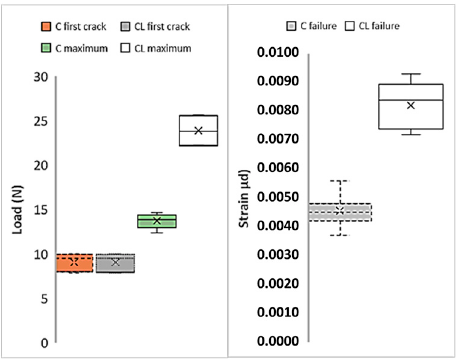
Figure 8. Variations of the critical points of the tensile test results of the M60 matrix composites.